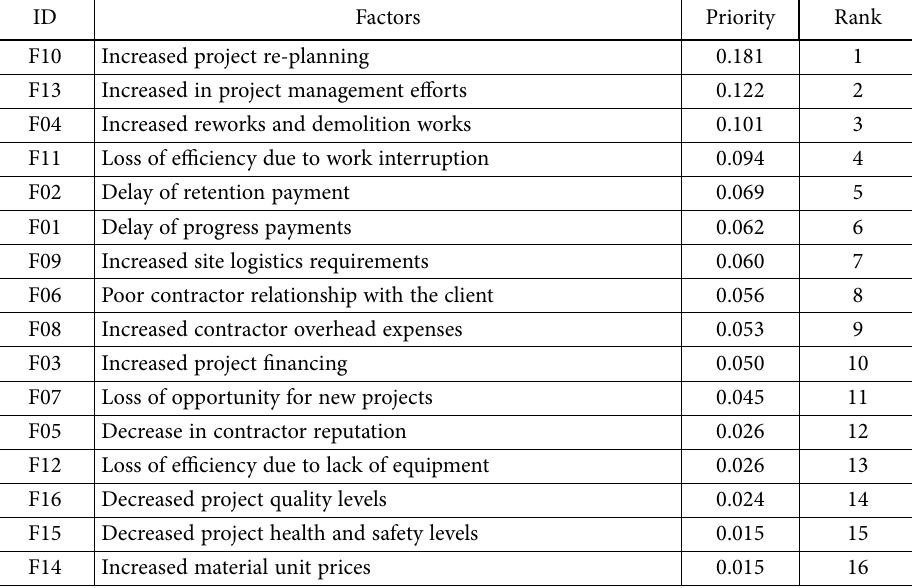
Table 9. Factors overall ranking using